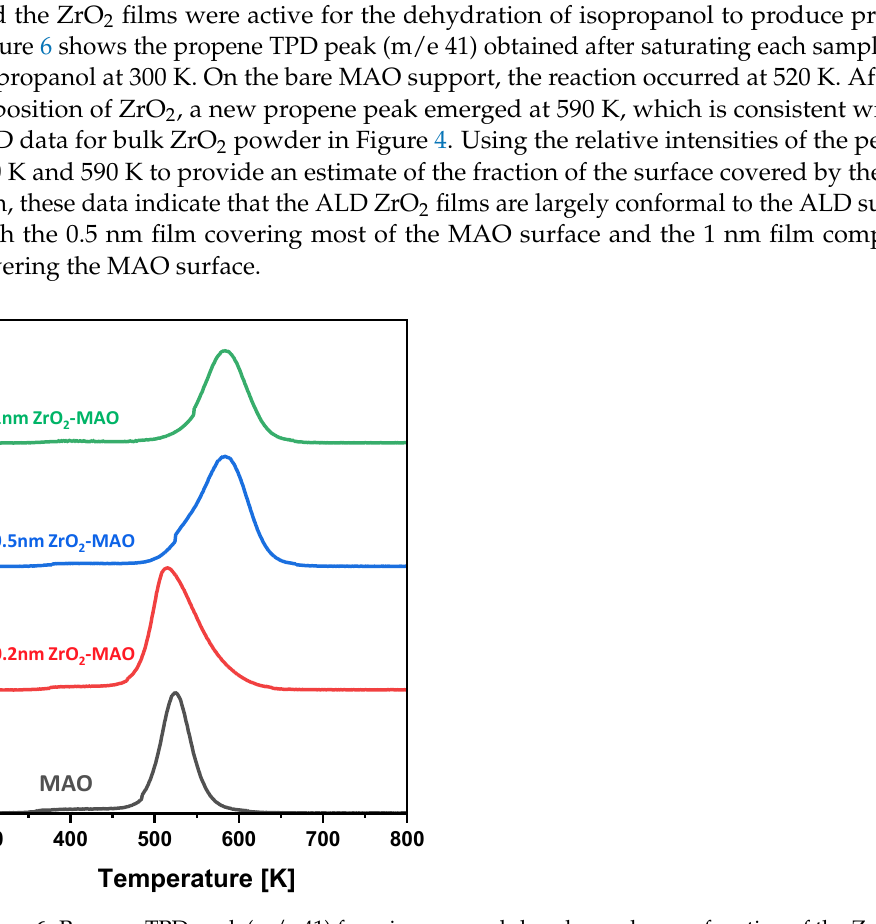
Figure 6. Propene TPD peak (m/e 41) from isopropanol-dosed samples as a function of the ZrO 2 film thickness.